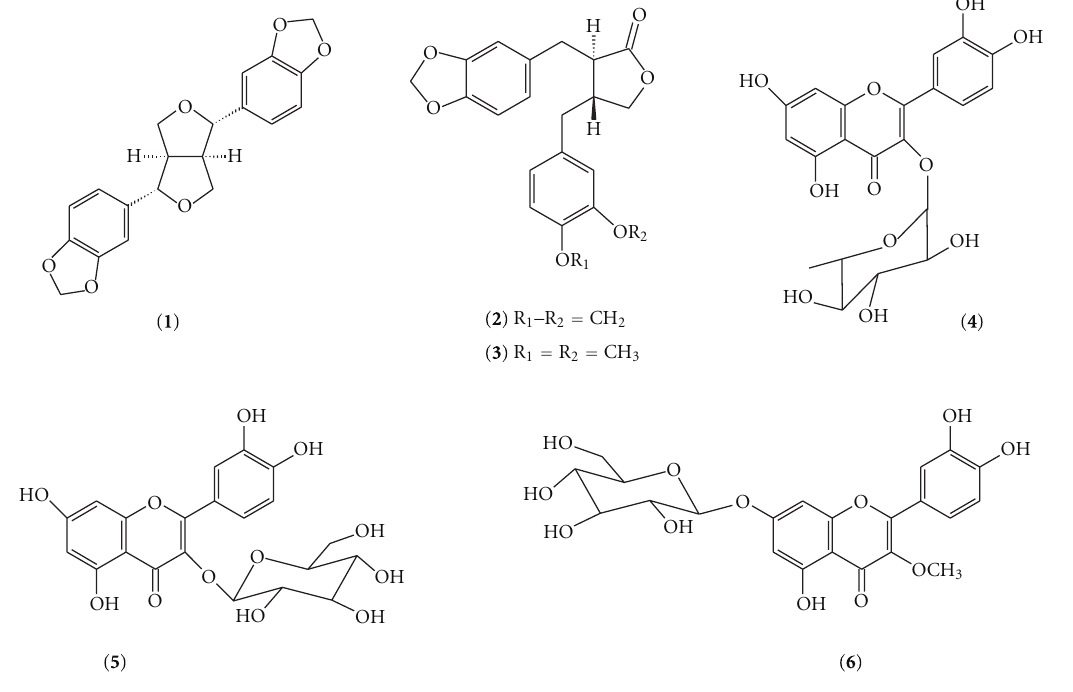
Figure 1: Chemical structures of the isolated compounds from V. sebifera